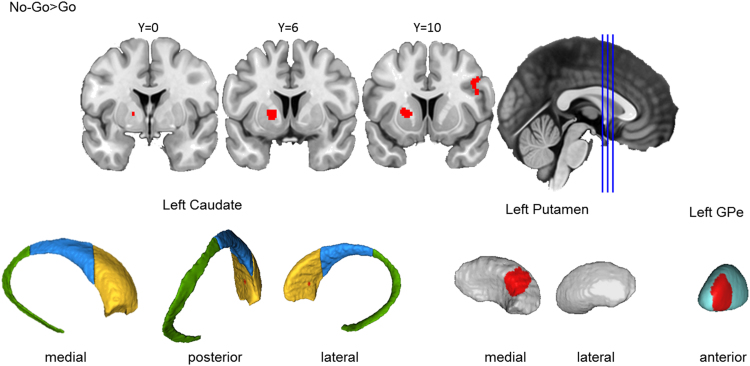
Basal ganglia activation for action prevention. Top row: Clusters are presented on coronal slices of a high-resolution MNI atlas. Reference lines for the coronal slices are presented in the sagittal plane. Bottom row: Clusters are displayed on high-resolution parcellations of the caudate, putamen, and external globus pallidus (GPe). All clusters are thresholded using cluster-level inference (p<.05, uncorrected p<.001, threshold permutations=1000).